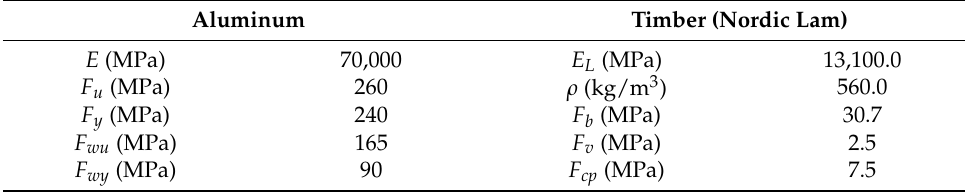
Table 1. The main mechanical properties of aluminum and